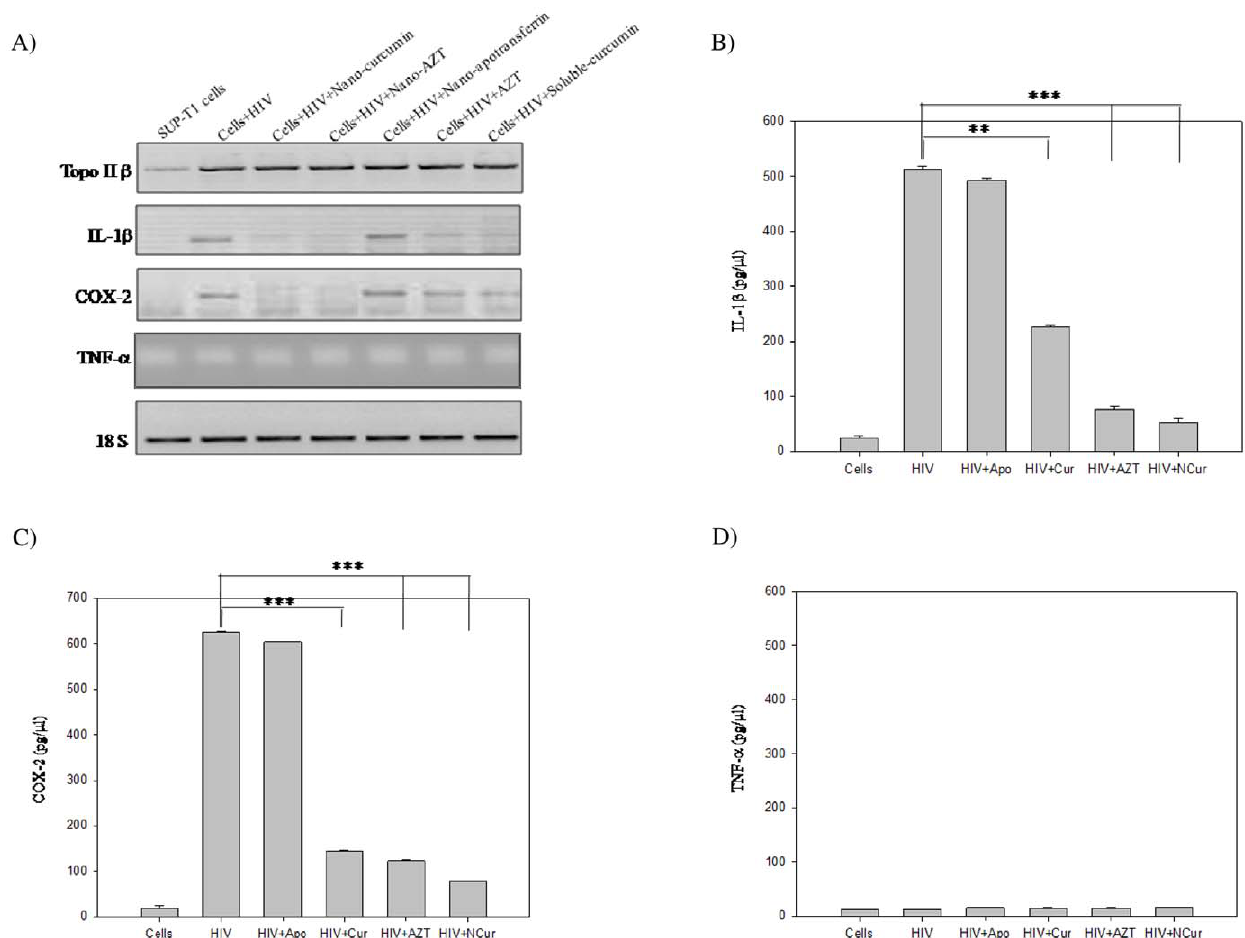
Figure 8. Action of nano-curcumin against virus-induced inflammatory response. A) SUPT1 cells were challenged for 4 h with HIV-1 93IN101 in the presence of 5 m M of sol-curcumin, nano-curcumin or nano-apotranferrin. The expression of topoisomerase II b , IL-1 b , TNF- a and COX-2 was determined by semi-quantitative-PCR. Template from normal SUP-T1 cells was used as negative control. 18S was used as an internal control in both experiments. IL-1 b (Panel B), COX-2 (Panel C) and TNF- a (Panel D) were estimated using commercial kits as described in the methods section. Error bars indicate SD. ***, P # 0.001 compared to nano-curcumin.